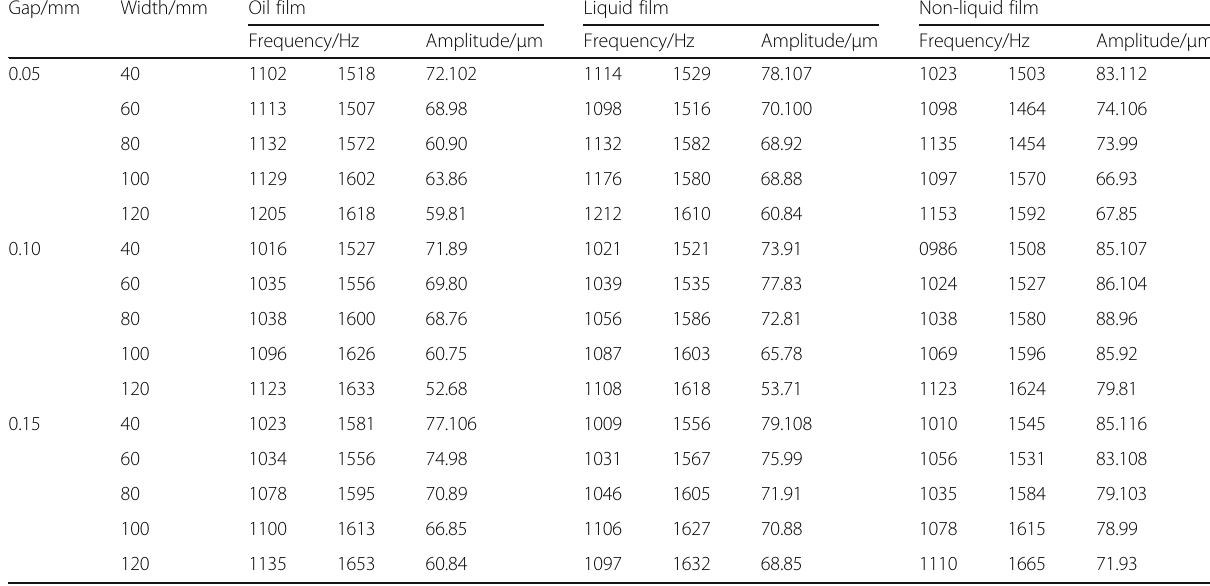
Table 4 Double damping oil film, liquid membrane for the main shaft frequency and amplitude Gap/mm